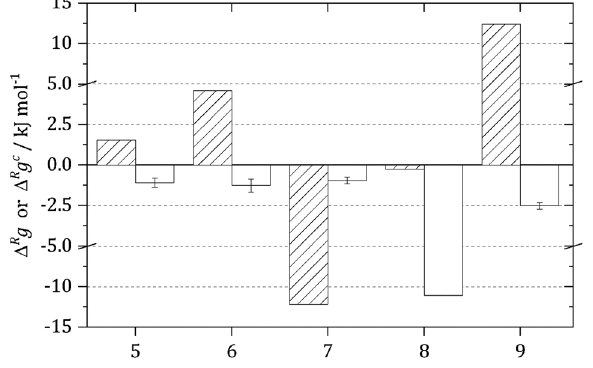
Figure 2. Comparison of the concentration-based Gibbs energy of reaction (cid:31) R g c (striped bars) and the activity-based Gibbs energy of reaction (cid:31) R g (white bars) of the glycolytic TPI reaction (reaction 5), GAPDH reaction (reaction 6), PGK reaction (reaction 7), PGAM reaction (reaction 8) and enolase reaction (reaction 9) at 298.15 K, pH 7.0; reaction conditions listed in Table